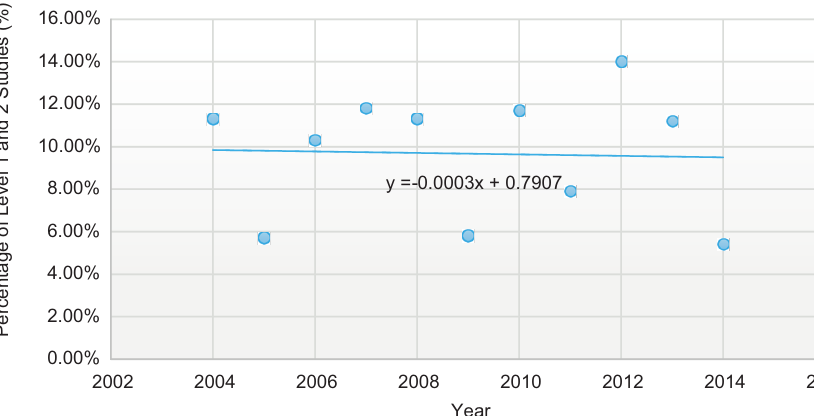
Figure 2. Percentage of Level 1 and 2 global orthopaedic studies conducted in low- and middle-income countries per year from June 2004 to June 2014.